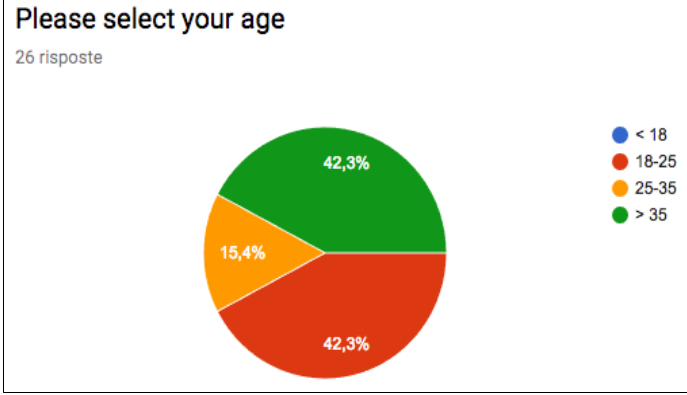
Figure 3. Age distribution of users